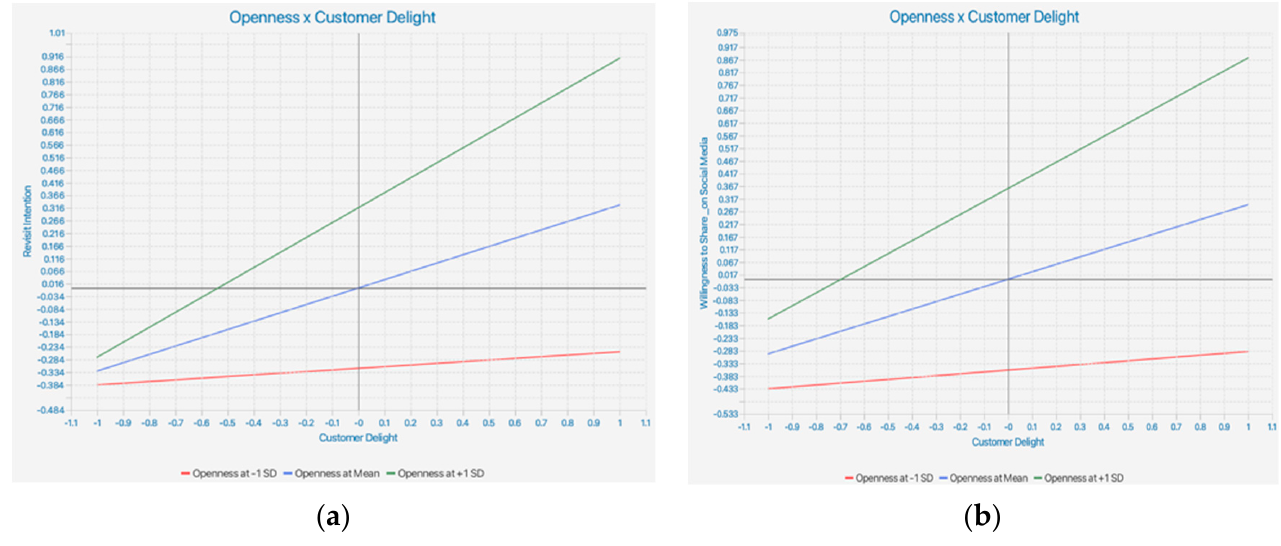
Figure 2. Simple slope analysis: ( a ) Moderation effect of OPS on the impact of CDL to RVI; ( b ) Mod- eration effect of OPS on the impact of CDL to